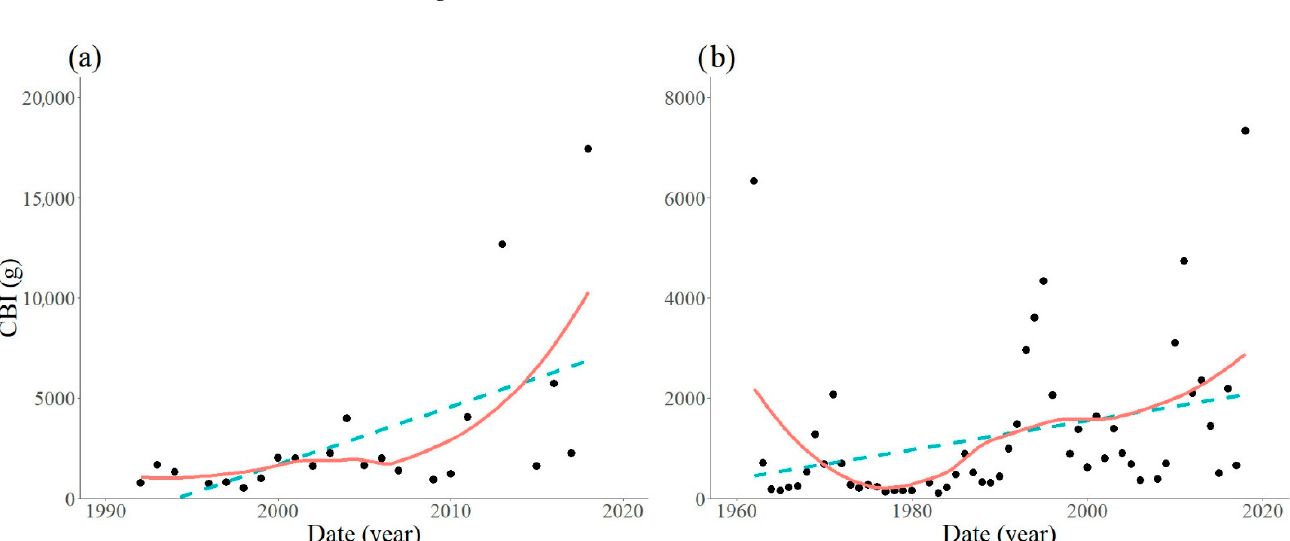
Figure 4. Yearly values and long term trends of the estimated spring caterpillar mass at Bakonybél ( a ), and Fels ő tárkány ( b ). (CBI, Caterpillar Biomass Index; blue dashed line, linear regression; red line, locally weighted regression with α = 0.8).